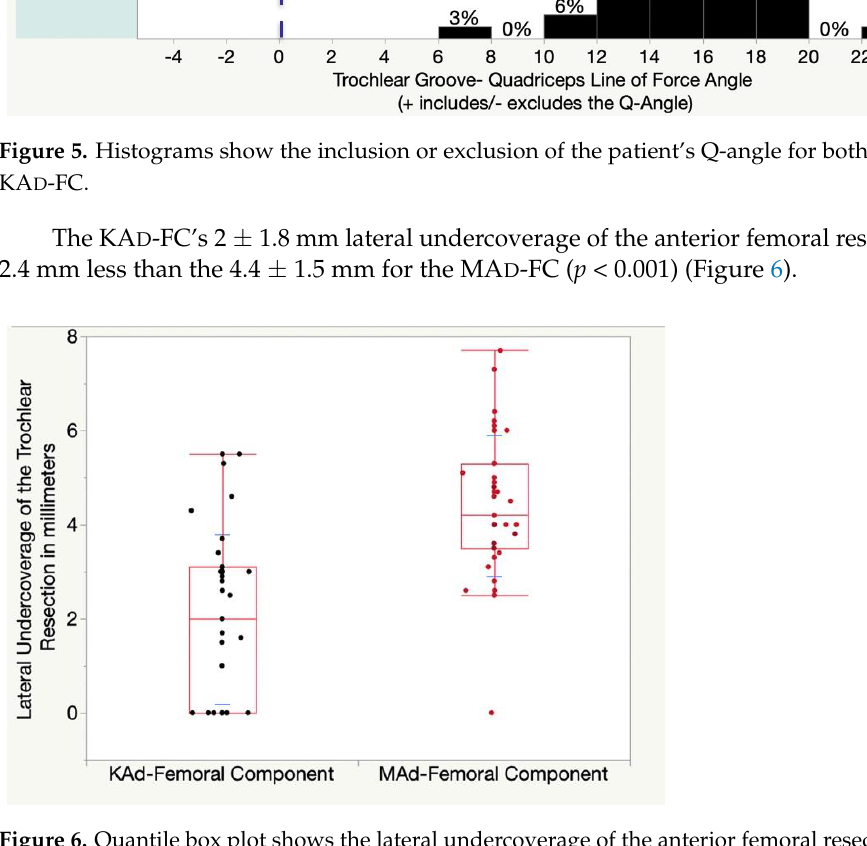
Figure 6. Quantile box plot shows the lateral undercoverage of the anterior femoral resection for the KA D - (black points) and MA D -FC (red points). Standard deviations are illustrated by blue